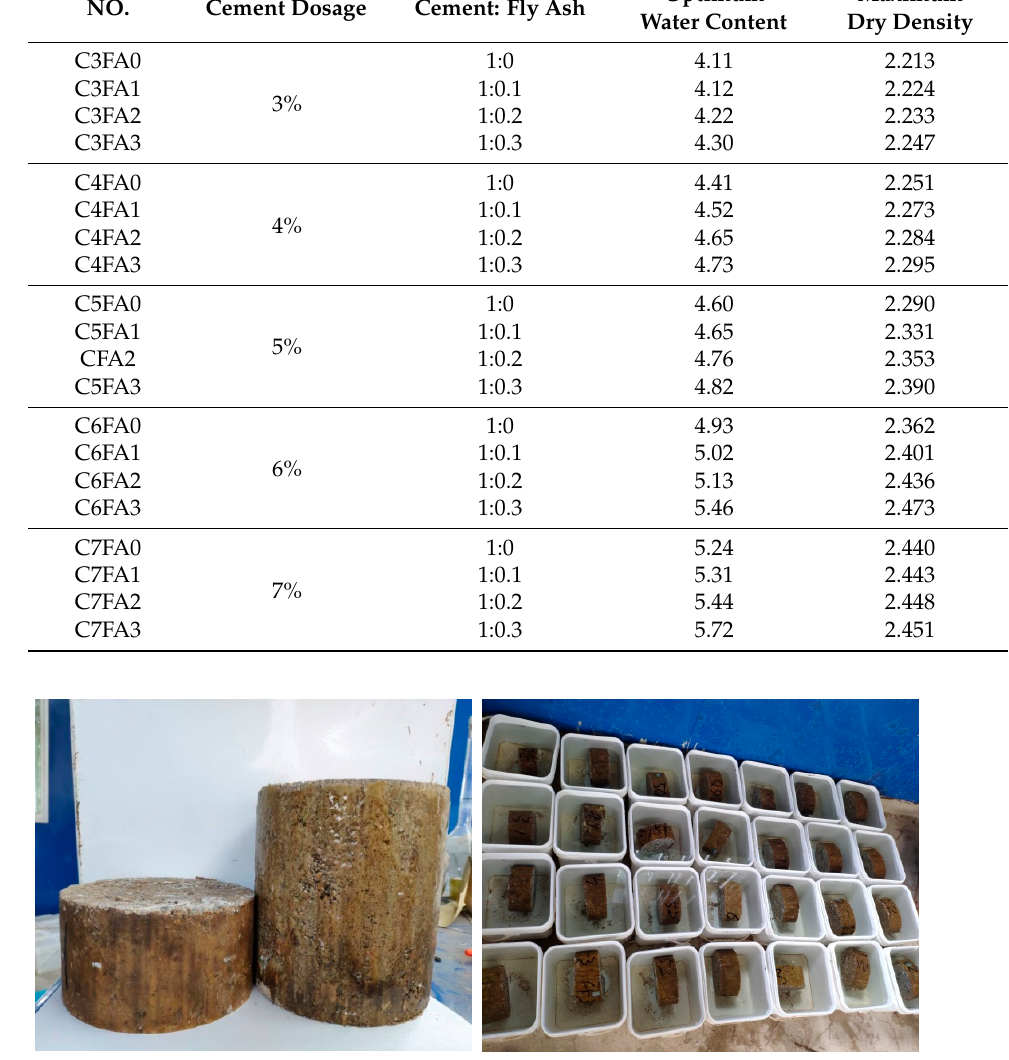
Figure 1. Cement-stabilized macadam samples.